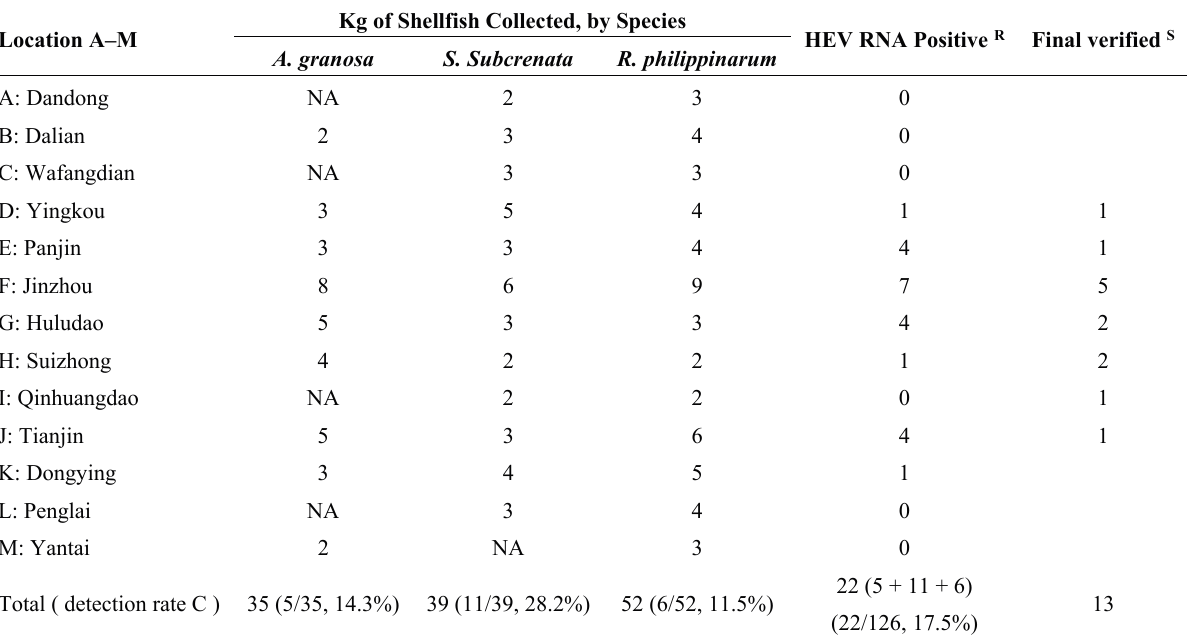
Table 1. Statistics of HEV-positive detection rate by percentage per kg of each species of